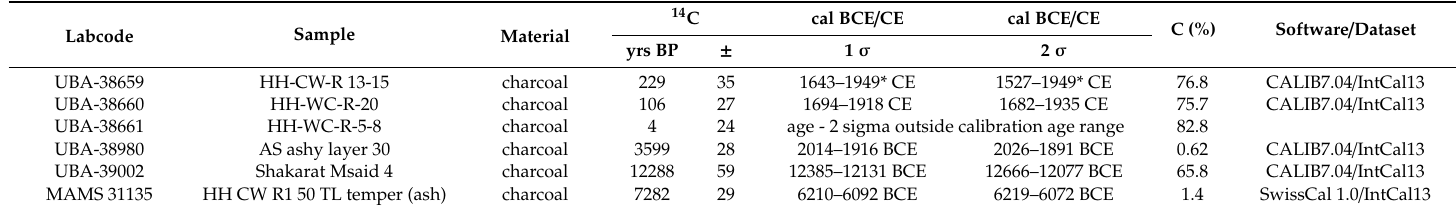
Table A6. Summary of radiocarbon dating results.